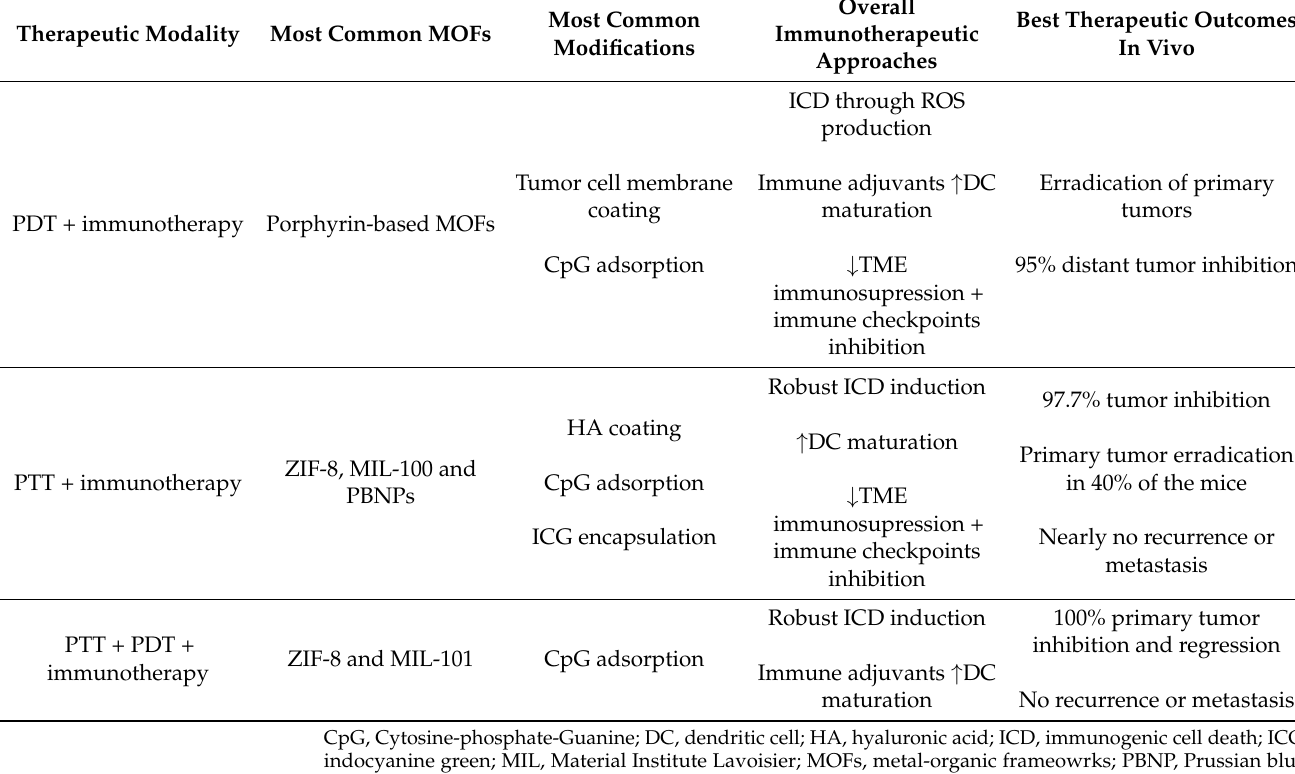
Table 2. Overall summary of the strategies employed in the reviewed